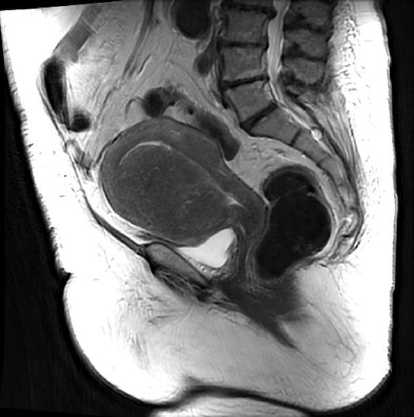
Figure 10. MELF endometrial carcinoma. Sagittal T2-weighted image showing the thickening of the inner part of the anterior myometrium and a low-signal-intensity adenomyosis-like mass with tiny cystic components.